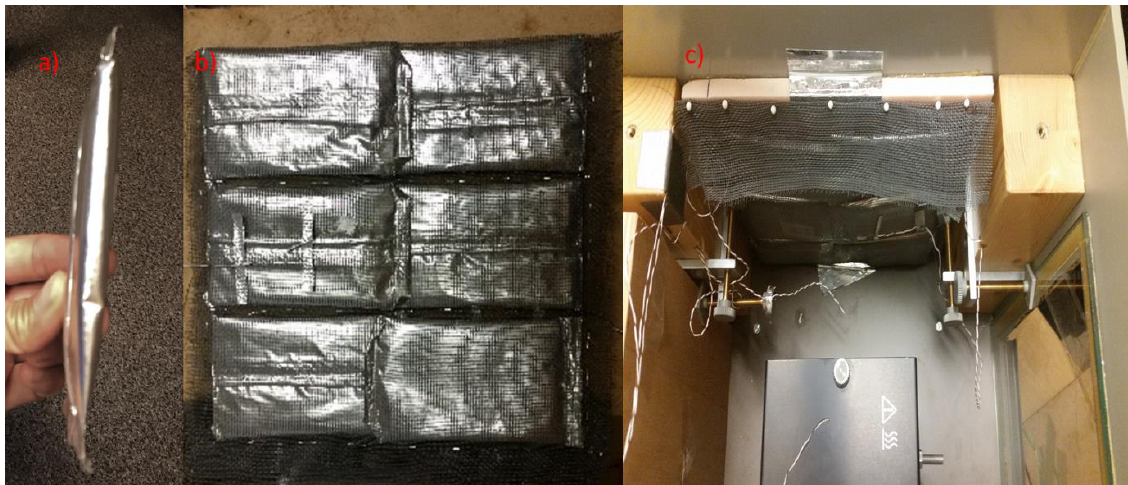
Figure 7. PCM used in the study: ( a ) a PCM bag; ( b ) six PCM bags enclosed into a polymer net; ( c ) PCM bags fixed onto an XPS wall.